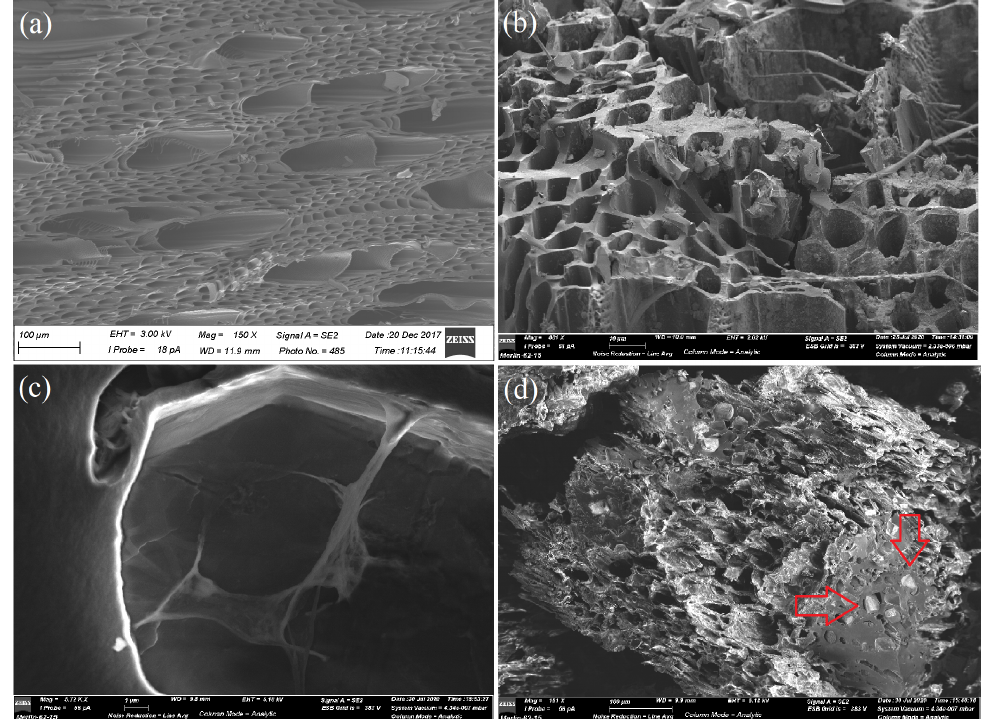
Figure 2. Scanning electron microscopy of biochar from Betula alba (( a )—sample before application at 100 µ m magnification, ( b )—sample after 1-year application at 10 µ m magnification, ( c )—sample after 2-year application at 1 µ m magnification, ( d )—sample after 2-year application at 100 µ m